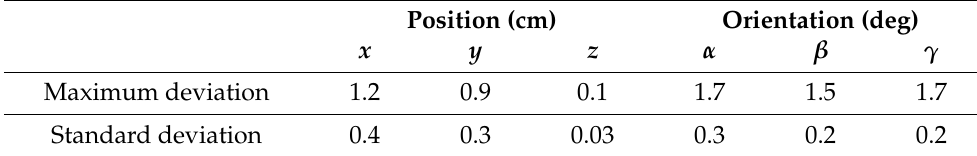
Figure 15. Performance of the WR position teleoperation for the third experiment. First three graphs: user position references in thin red line, actual position values of the workpiece in thick blue line, and position limits given by the 3D boundary constraint in dashed lines. Bottom graph: activation of the 3D boundary constraint for the workpiece position. Table 3. Teleoperation errors for the pose p w (i.e., position and orientation) of the